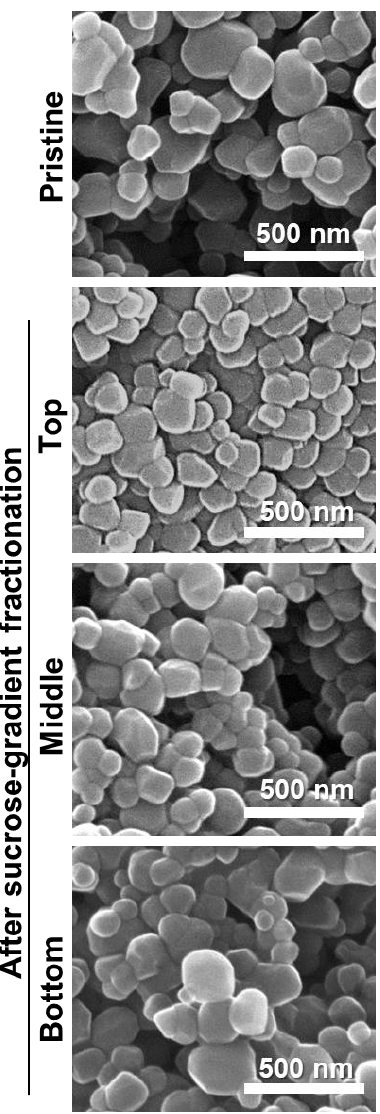
Figure 5. Scanning electron microscopy (SEM) images of TiO 2 (T4) in the top, middle, and bottom layers fractionated by a sucrose gradient method.